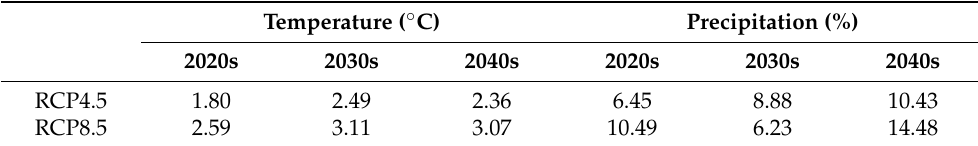
Table 6. Climate change for future periods under two different RCPs relative to 1961–2016.